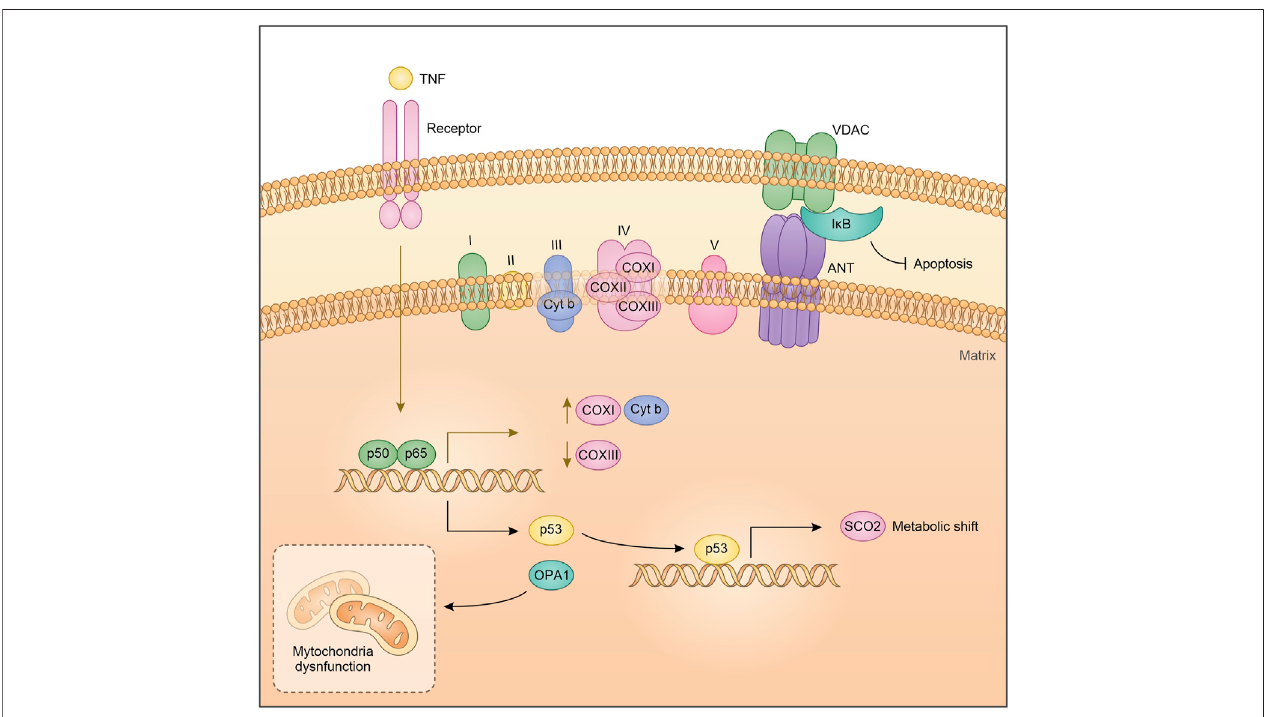
FIGURE 1 | Schematic representation of NF- κ B crosstalk in the